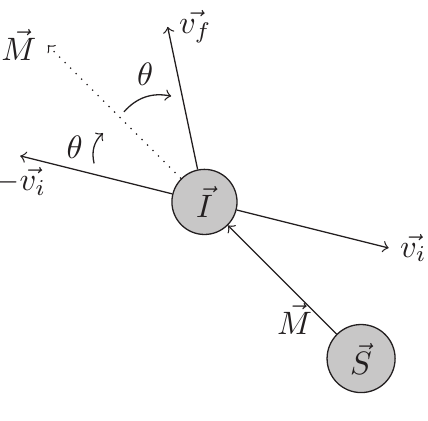
Figure 2. Pinball